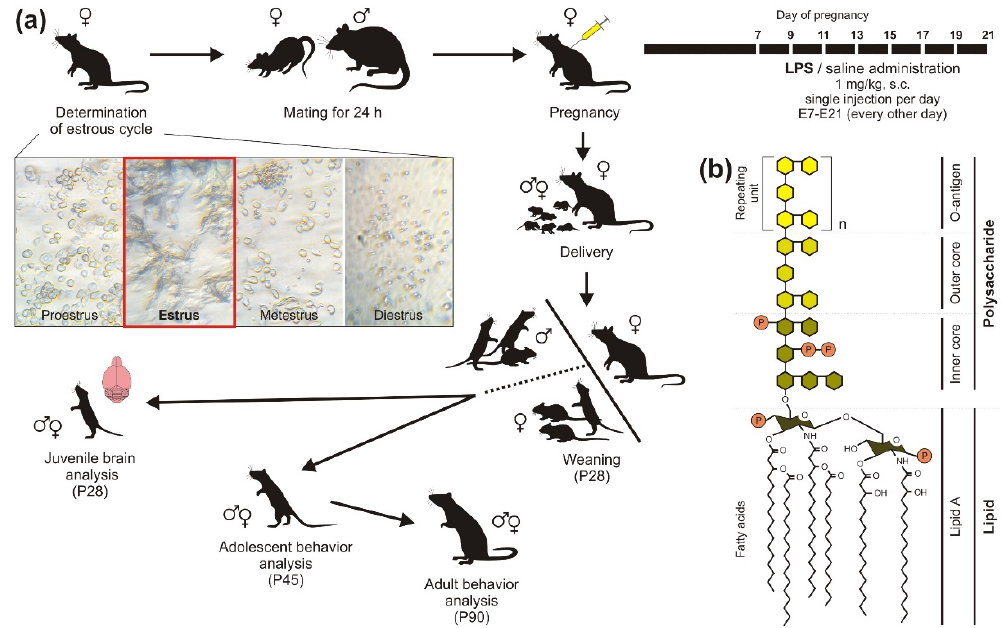
Figure 7. ( a ) The design of the experiment. In rat females, estrous cycle was determined for approximately one week. Estral females were mated with a male for 24 h. During pregnancy, females received six subcutaneous (s.c.) injections of lipopolysaccharide (LPS) at a dose of 1 mg/kg, or 0.9% saline solution (control), from embryonic day E7 to E21 (delivery), every other day. The offspring of both sexes were used for brain analysis at postnatal day P28 (weaning) or for the behavioral testing in adolescence (P45), which was repeated in adulthood (P90). ( b ) The structure of a bacterial LPS; according to [36].